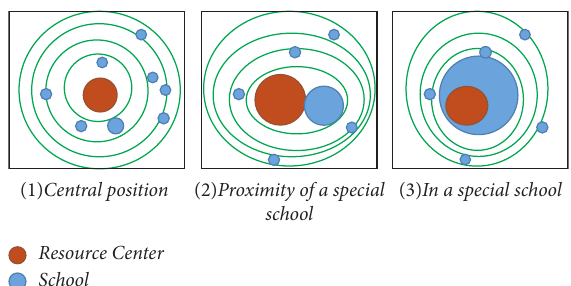
Figure 6: Location and layout of special education resource